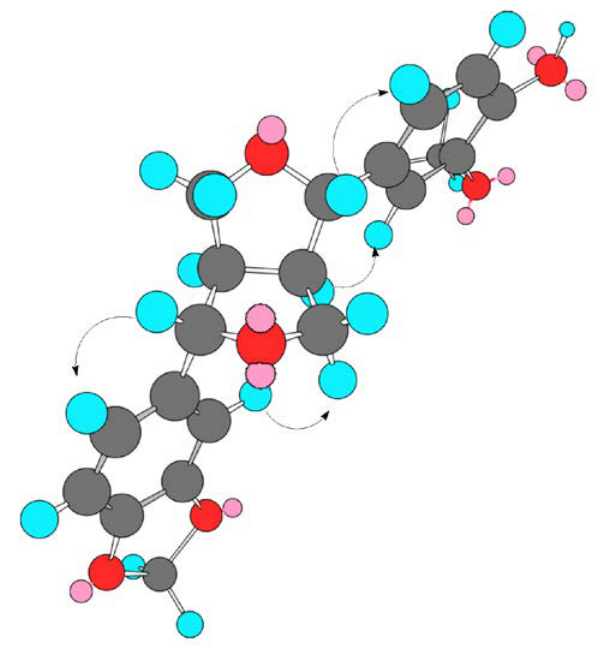
Figure 7. A 3D structure of the furofuran lignan aglycone obtained by computer imaging (Chem Draw 3D) showing the major interactions observed in the NOESY experiment.